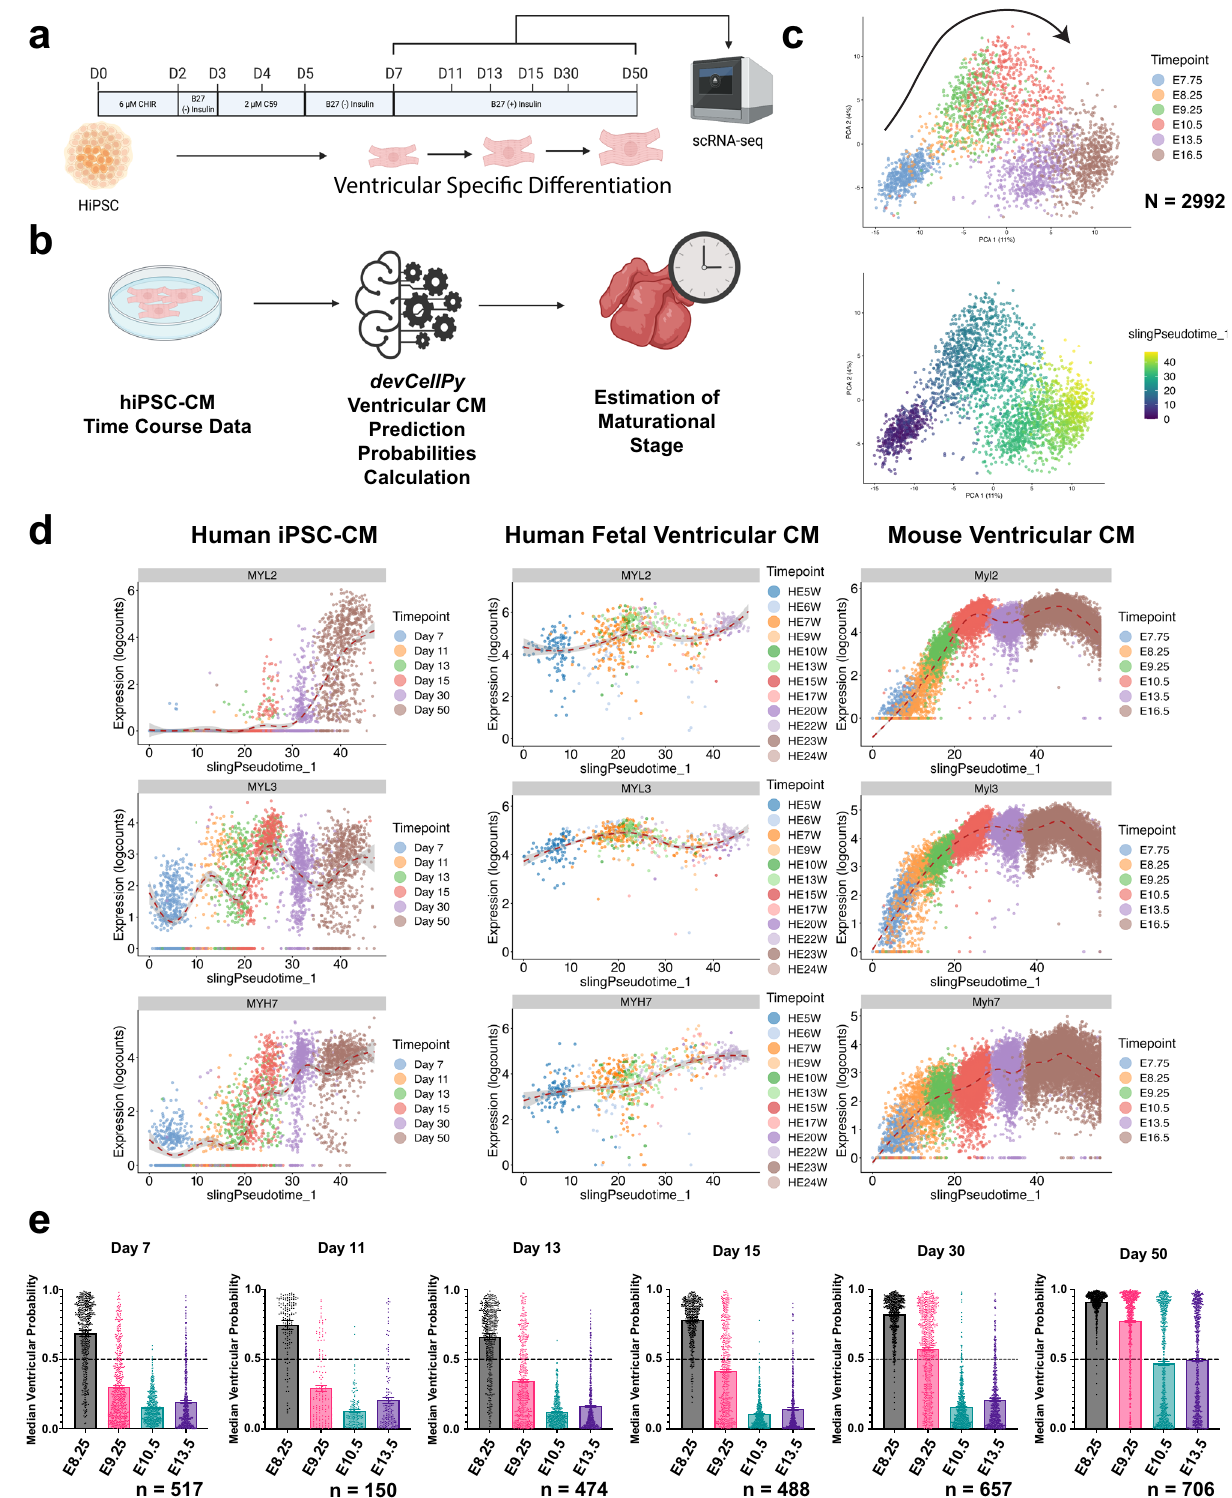
Fig.7| devCellPy murinepredictionmodelsidentifydevelopmentalimmaturity of ventricular predominant HiPSC-CMs. Human iPSC-derived cardiomyocytes (hiPSC-CMs)weredifferentiatedanddissociatedatmultipletimepointsforscRNA-seq and evaluation of maturationalstate using devCellPy . a Overview of protocolused for scRNA-seq time course of hiPSC-CMs. b Schematic of work fl ow for prediction of hiPSC-CM subtypes using devCellPy model trained on murine cardiomyocyte data. c Plots of hiPSC-CM scRNA-seq time course data along the fi rst two principal com- ponents. Top, plot illustrates the transition of cardiomyocytes from early day 7 fol- lowed by a progressive transition to day 50. Bottom, plot illustrates pseudotime